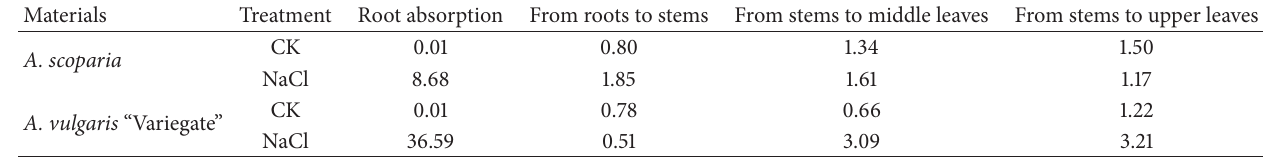
Table 8: Effect of NaCl stress on absorbing and transporting selectivity ratios of Ca 2+ to Na + in seedlings. Materials Treatment